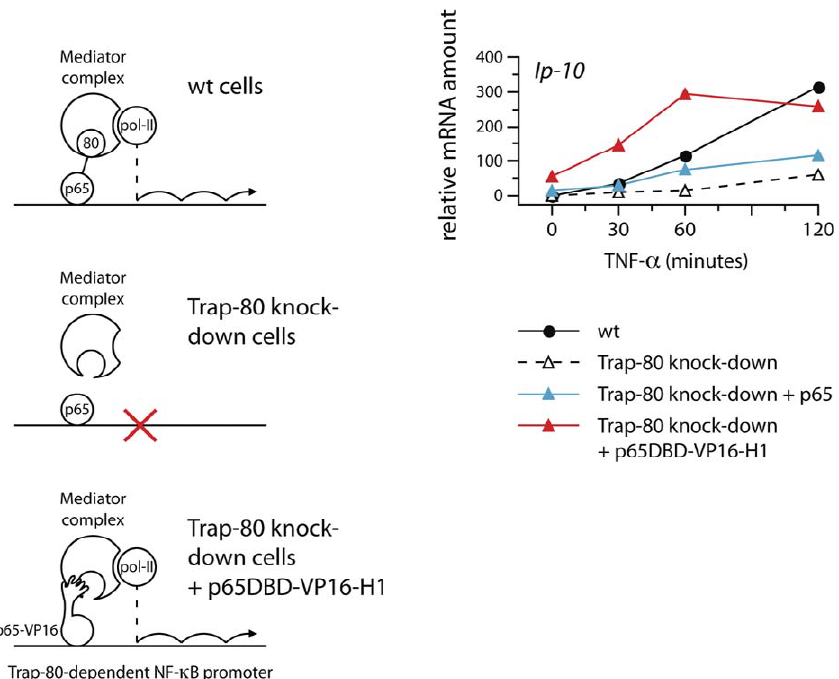
Figure 4. Artificial Contact with Mediator Rescues Expression of Trap-80–Dependent Genes The experimental rationale is depicted schematically on the left. On the right, Trap-80 knock-down fibroblasts were transduced with a retrovirus driving expression of full-length p65 (blue triangles), or of a fusion of the p65 DBD with the H1 region of VP16 (p65DBD-VP16-H1; red triangles), and expression of Ip-10 mRNA was compared to wild-type (wt) and untransduced Trap-80 knock-down cells. The result is representative of five experiments. Similar fusions using both the H1 and H2 regions of VP16, or fusions to full-length p65, gave the same results (not shown).